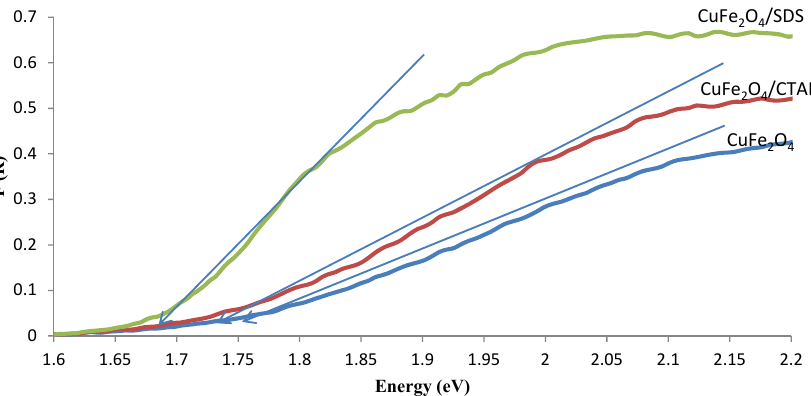
Fig. 7. The Kubelka–Munk plots of NiFe